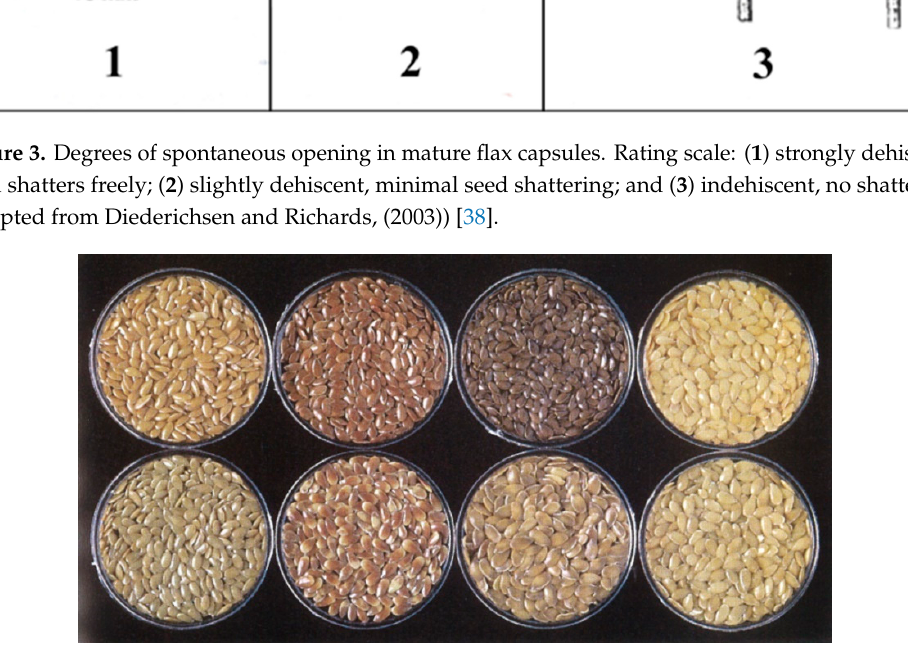
Figure 3. Degrees of spontaneous opening in mature flax capsules. Rating scale: ( 1 ) strongly dehiscent, seed shatters freely; ( 2 ) slightly dehiscent, minimal seed shattering; and ( 3 ) indehiscent, no shattering (adapted from Diederichsen and Richards, (2003)) [38].